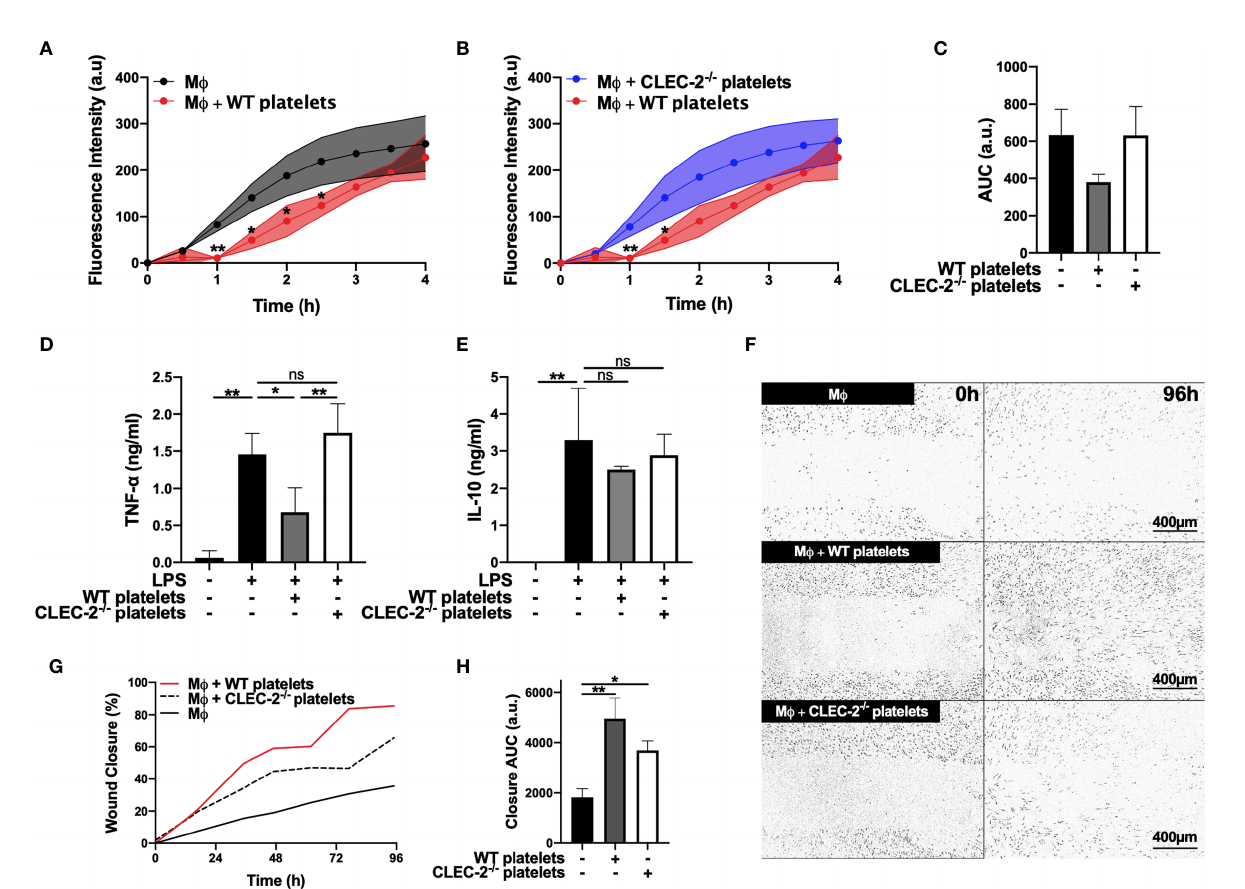
FIGURE 1 | Platelet CLEC-2 delays in fl ammatory BMDM phagocytic capacity and reduces TNF- a secretion (A – C) pH sensitive Alexa Fluor-488 conjugated Escherichia Coli bioparticles (3x10 6 beads/condition) were added to LPS-treated BMDM (M f ) in the absence or presence of (A) WT platelets or (B) CLEC-2-de fi